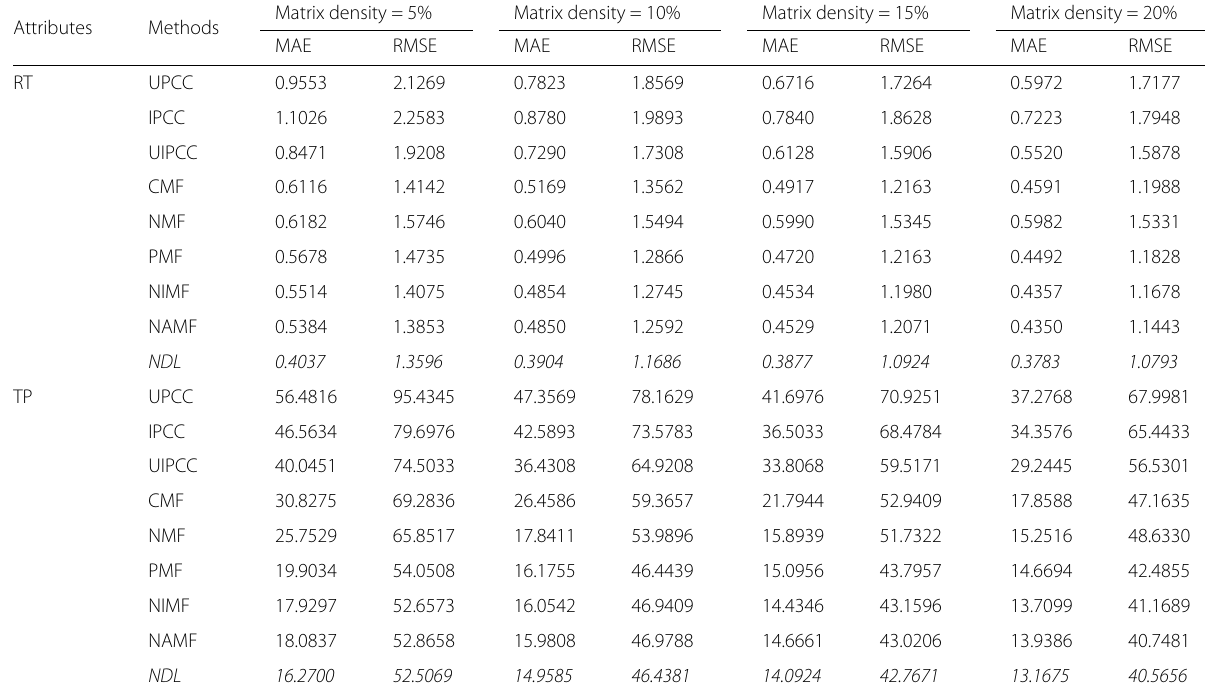
Table 2 Comparison of MAE and RMSE on the WS-DREAM dataset Attributes